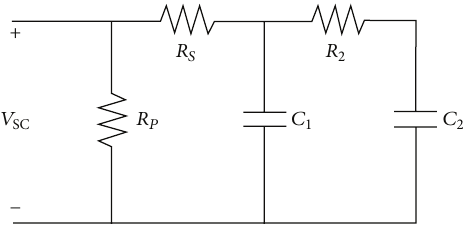
Figure 5: Variation of Δ𝑃 .